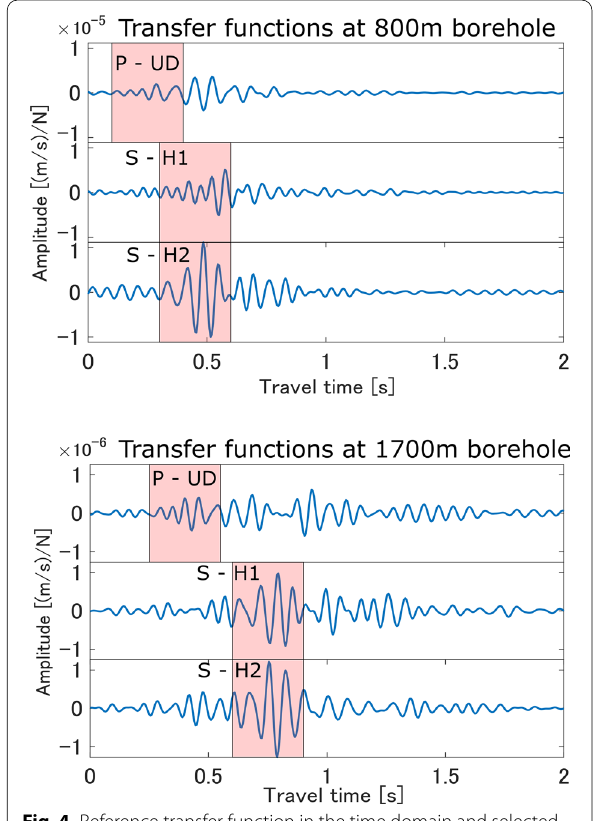
Fig. 4 Reference transfer function in the time domain and selected P and S phases for the 800-m and 1700-m sensors. Transfer functions on 14:00 January 19, 2000, are used as references. The area with the red area shows the P and S phases selected for calculating the change in amplitude and travel time. We selected P waves from the UD component (P-UD) and S waves from two horizontal components (S-H1 and